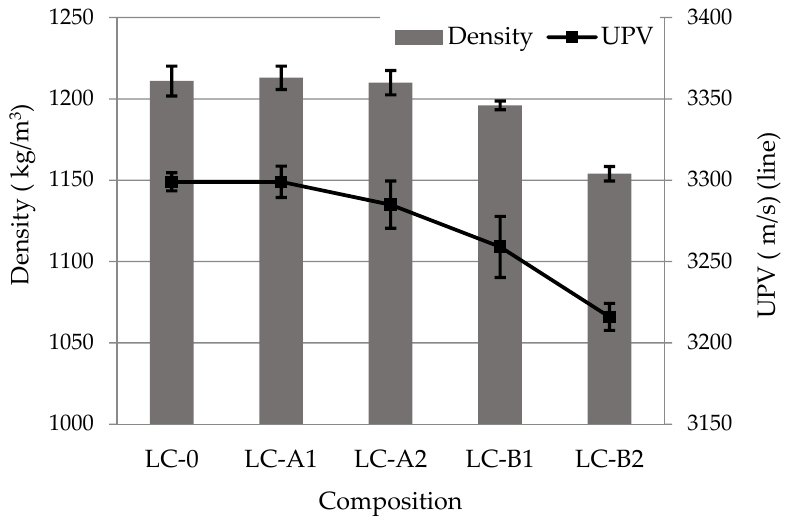
Figure 2. Density and UPV results in lightweight composites containing GEG after 28 days.